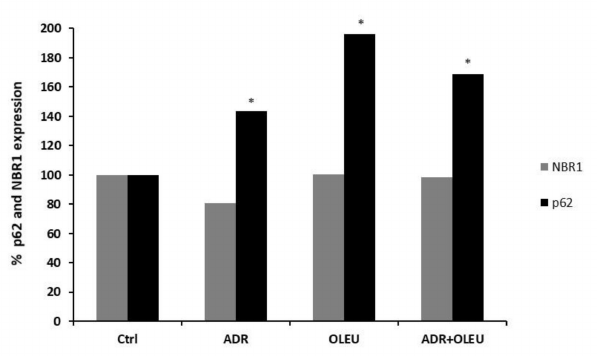
Figure 5. Representative graph of expression levels of NBR1 and p62 autophagy-related proteins in MG-63 cells after ADR (Adriamycin), OLEU (Oleuropein), ADR + OLEU treatments. * p < 0.05 compared to control cells. NBR1: neighbour of BRCA1 gene 1 protein; p62: ubiquitin-binding protein p62.